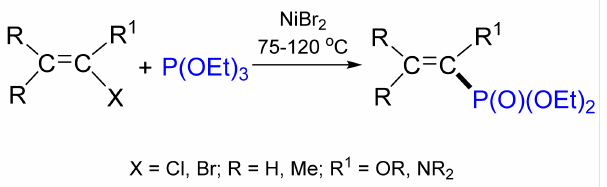
Figure 29. The reactions of triethylphosphite with alkenyl halides having an alkoxy or diethy- lamino